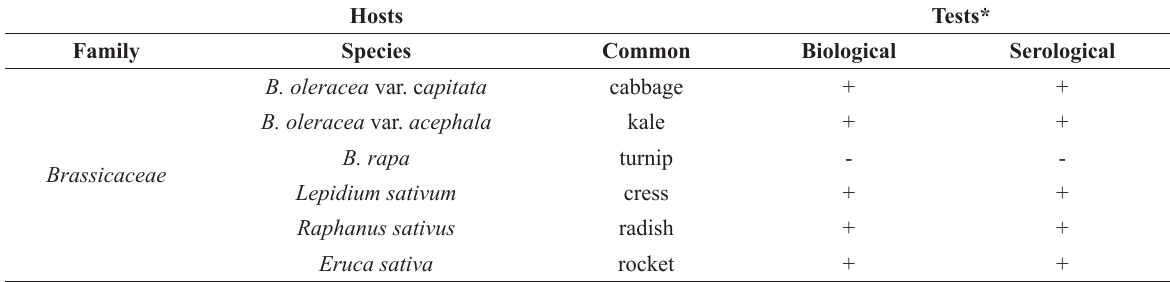
Reaction of host plants to sap inoculation by the viruses and serological